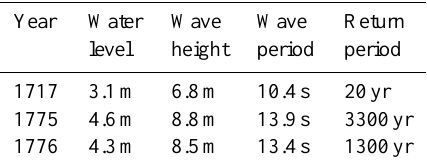
Table 3. Estimated magnitude of the three largest storm surges of the 18th century at the northern Holland